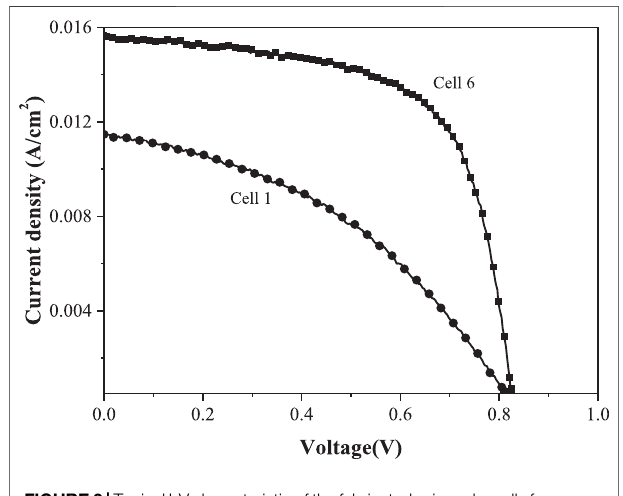
FIGURE3| TypicalI-Vcharacteristicofthefabricated p-i-nsolarcellsfor two different masking techniques ( ■ Metal Mask + ultrasound soldering; C Metal mask)